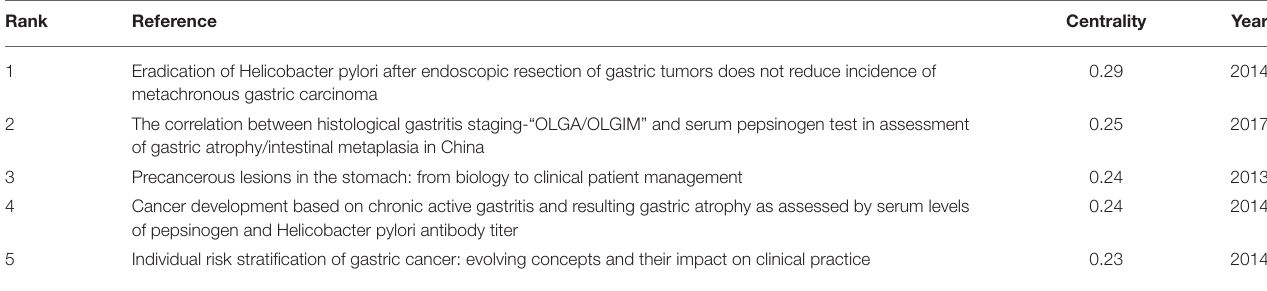
TABLE 5 | Top 5 co-cited references with the highest centrality in AG